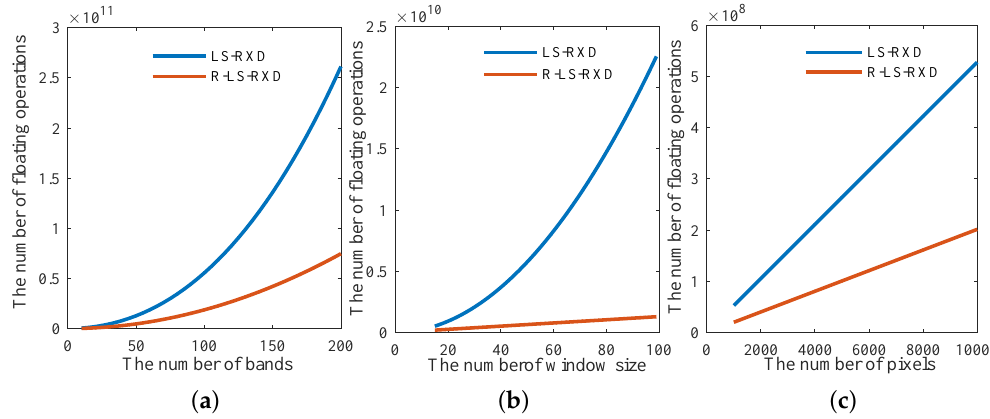
Figure 5. Numbers of floating operations in various of ( a ) bands; ( b ) ω size; ( c ) processed pixels.